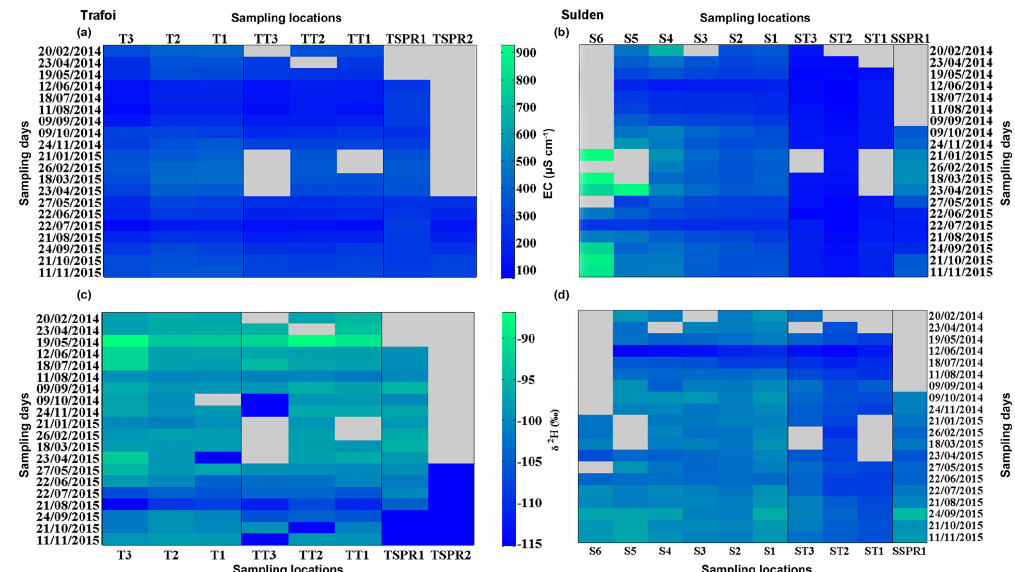
Figure 4. Spatial and temporal variability in EC (µScm − 1 ) and δ 2 H (‰) at different stream sections, tributaries and springs within the Trafoi sub-catchment (a, c) and the Sulden sub-catchment (b, d) in 2014 and 2015. The heat maps are grouped into locations at streams, tributaries and springs. Grey areas refer to missing sample values due to frozen or dried-out streams or tributaries or because the sampling location was included later in the sampling scheme.